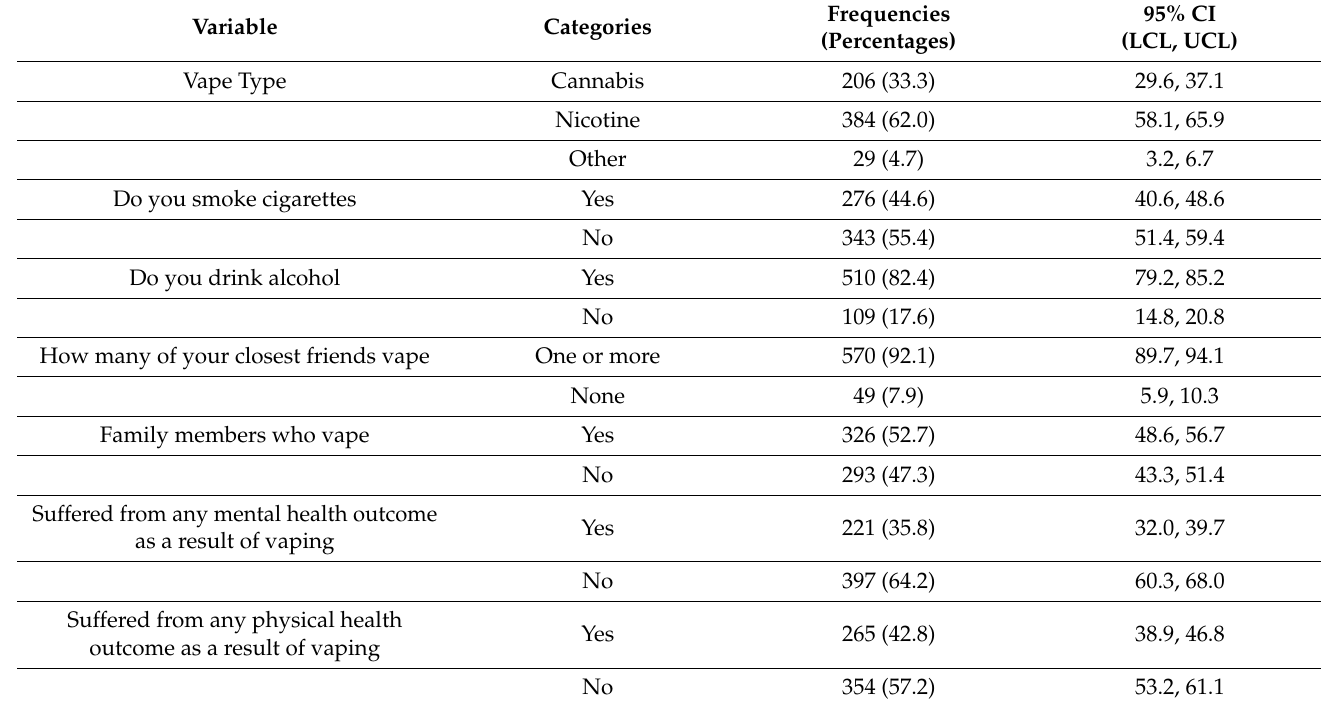
Table 3. Summary of variables related to vaping and other behaviors’ history (N = 619).